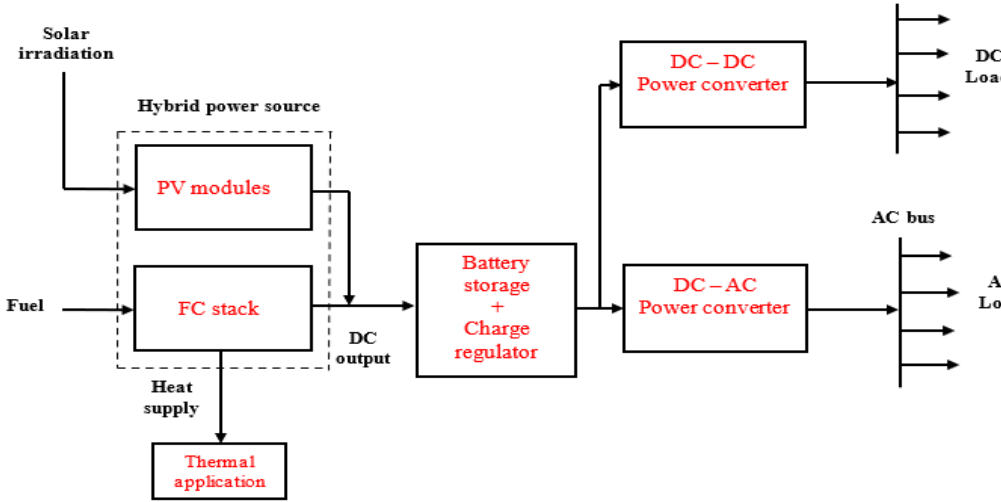
Figure 7. Stand-alone application based on FCs and fossil-fueled power sources. 3.1.4. Emergency or Backup Power In the emergency application, the microgrid system must not only possess the technical capability to meet a fast start-up but also be connected with a battery bank or another peaking plant [111]. The battery bank can offer a low backup power for a short duration (usually seconds to a few minutes); however, the FC stack can provide higher backup power in several kW with a longer duration of >30 min [111,118]. Both the electrolyzer and the hydrogen tank can be integrated with the FC microgrid used in backup power mode. The significance of this is that the system will be capable of producing its fuel (i.e., H 2 ) at those periods when electricity is imported from the grid [111]. The electrolyzer consumes electricity to produce hydrogen by the process of electrolysis of water, while the purpose of the hydrogen tank is the storage of hydrogen generated by the electrolyzer for operating a hydrogen- fueled generator [127]. Such a system that makes use of an electrolyzer is known as the regenerative FC. An example of backup power is the uninterruptible power supply (UPS), which can supply